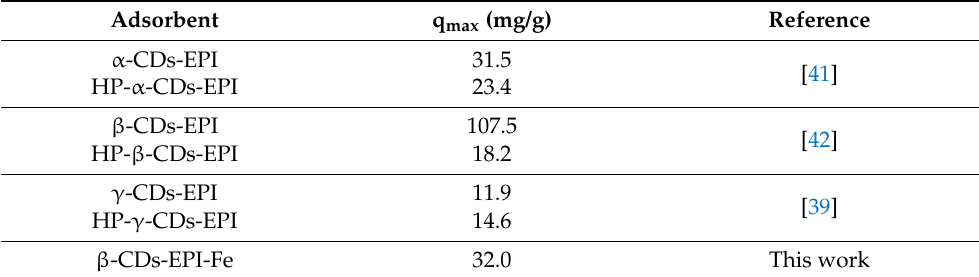
Table 3. The adsorption efficiency of different polymers to remove Direct Red 83:1.